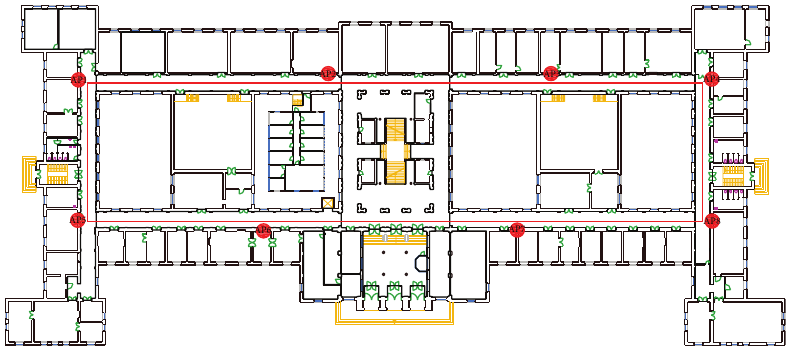
Figure 1: Experimental test bed.